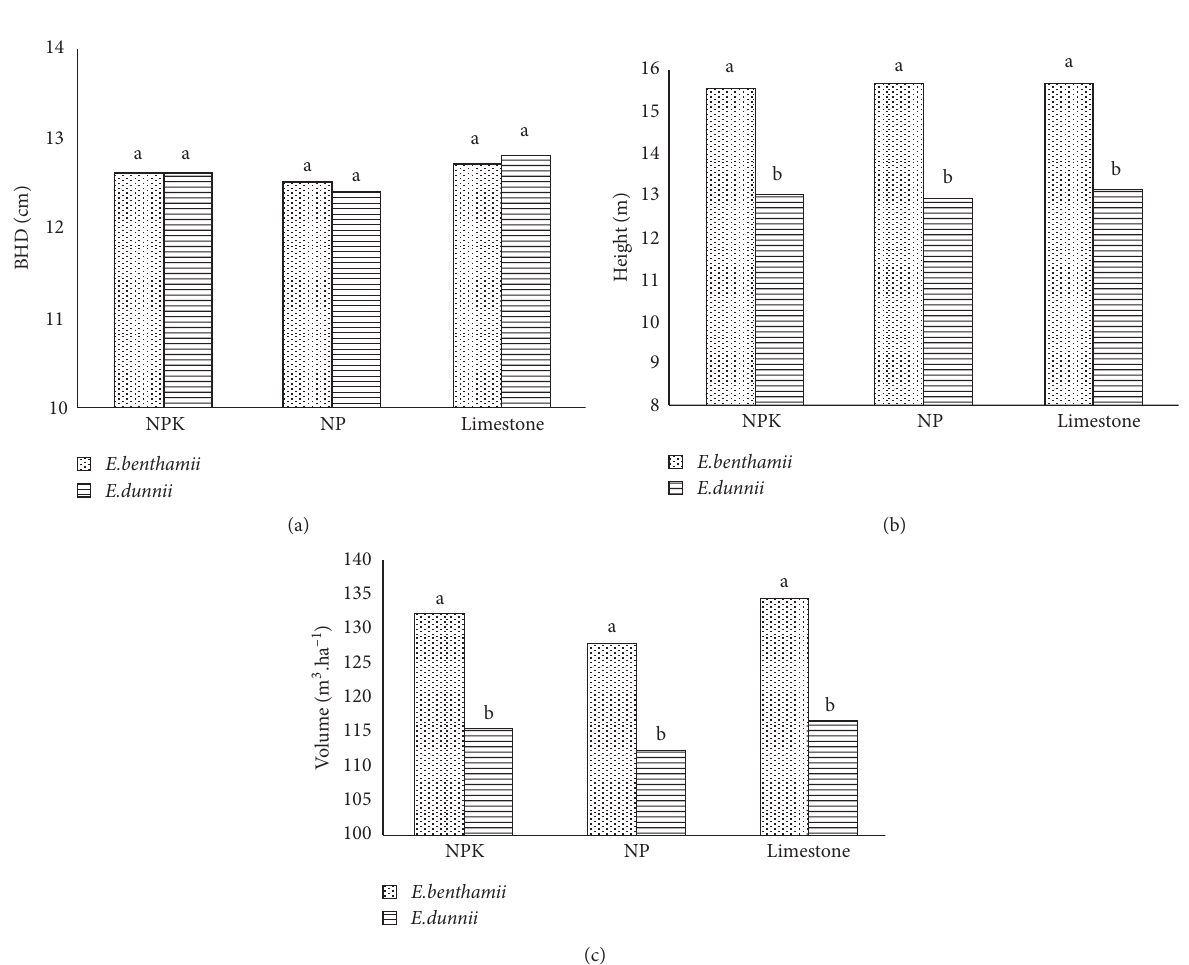
Figure 4: (a) Breast height diameter (BHD, cm), (b) height (m), and (c) volume (m3 ha − 1 ) in Eucalyptus benthamii and Eucalyptus dunnii . Averages followed by the same letter, lower and uppercase, do not differ between them by the Tukey test at 5% probability. Lowercase letters compare fertilization in relation to E. benthamii . Uppercase letters compare fertilization in relation to E. dunnii